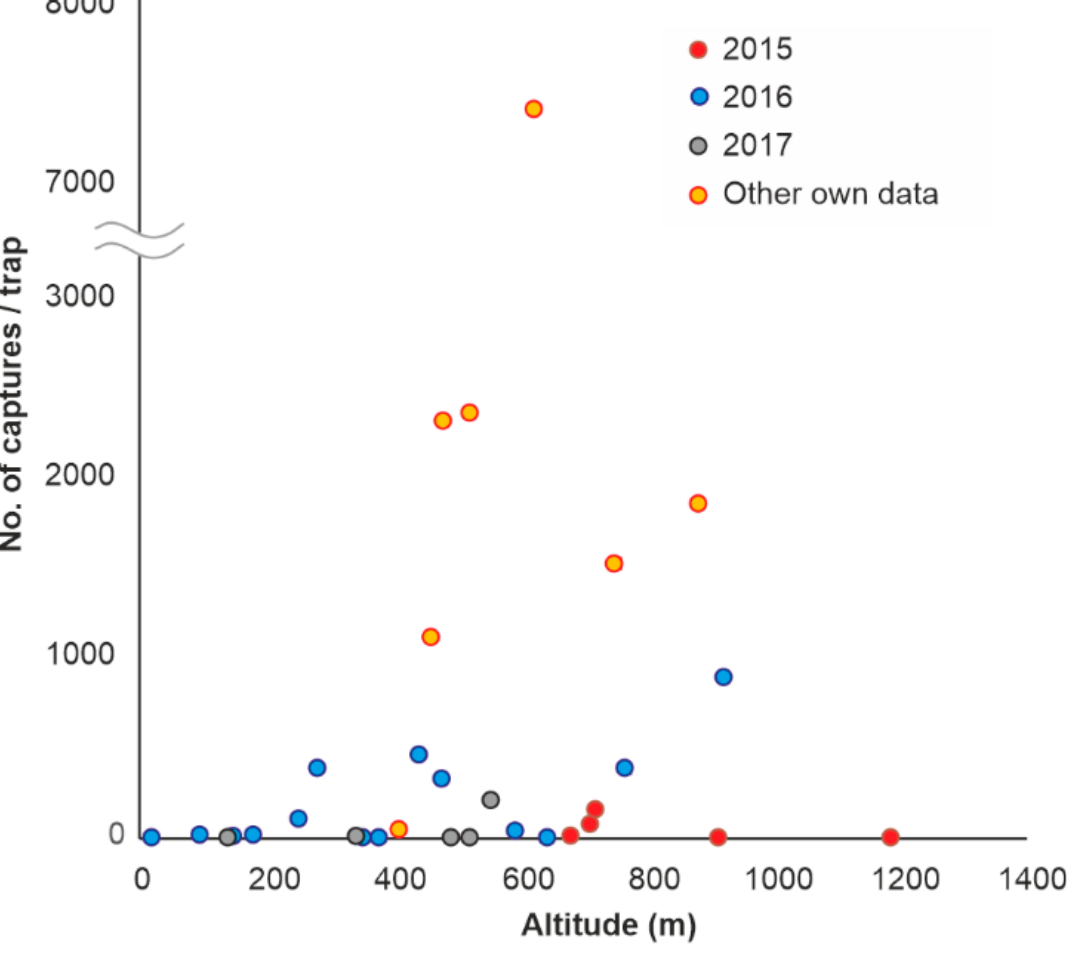
Figure 9. Variation of BSB captures with altitude in different years. Mainly studies carried out throughout the vegetation season were taken into